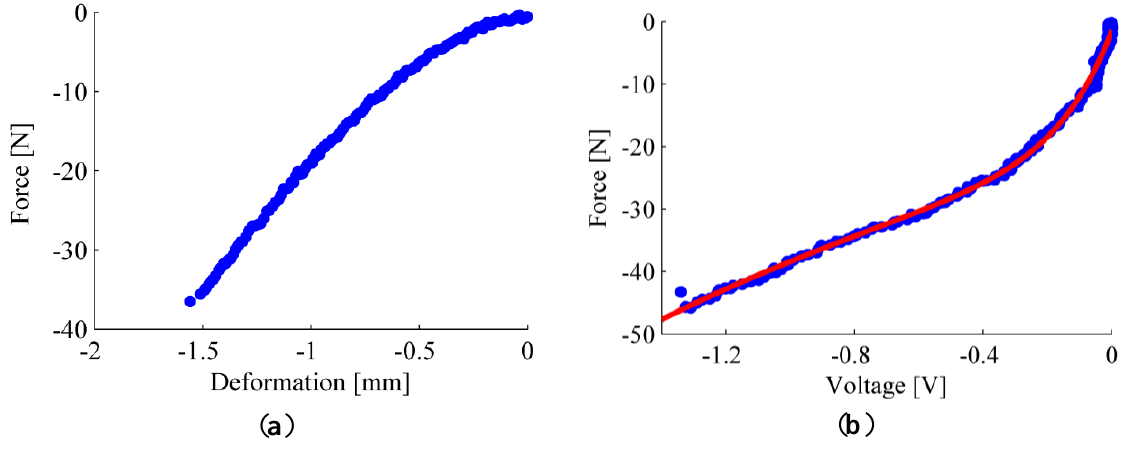
Figure 4. Characterization of one representative sensitive element: ( a ) quasi-static force-to-deformation characterization; ( b ) quasi-static force-to-output voltage curve, experimental data of one selected sensor (blue dots) and fitting model (solid red line).